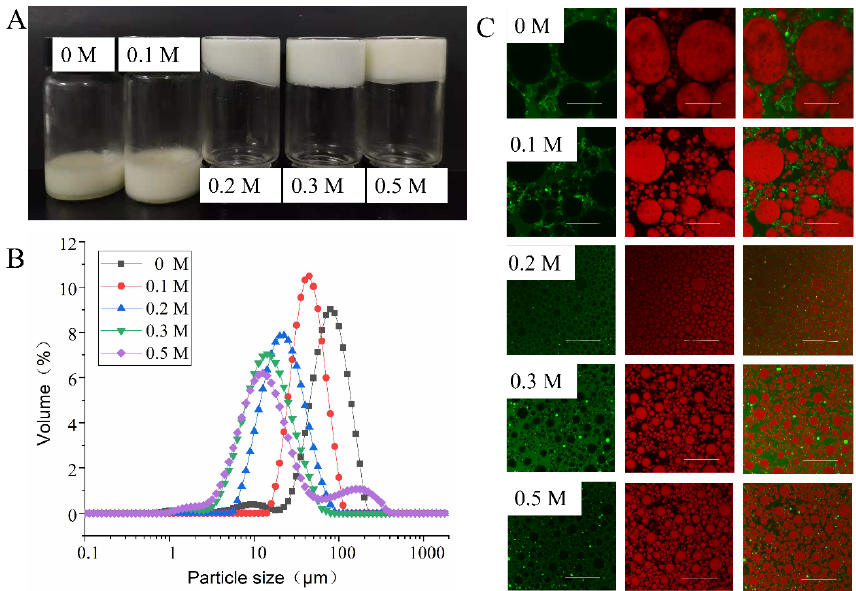
Figure 4. The visual observation ( A ), particle size distribution ( B ), and CLSM images ( C ) of HIPEs stabilized by EYGs at different NaCl ionic strengths. The concentration of EYGs was 3.0 wt%, and the volume of the oil phase was 0.8. The corresponding bar is 100 µm.